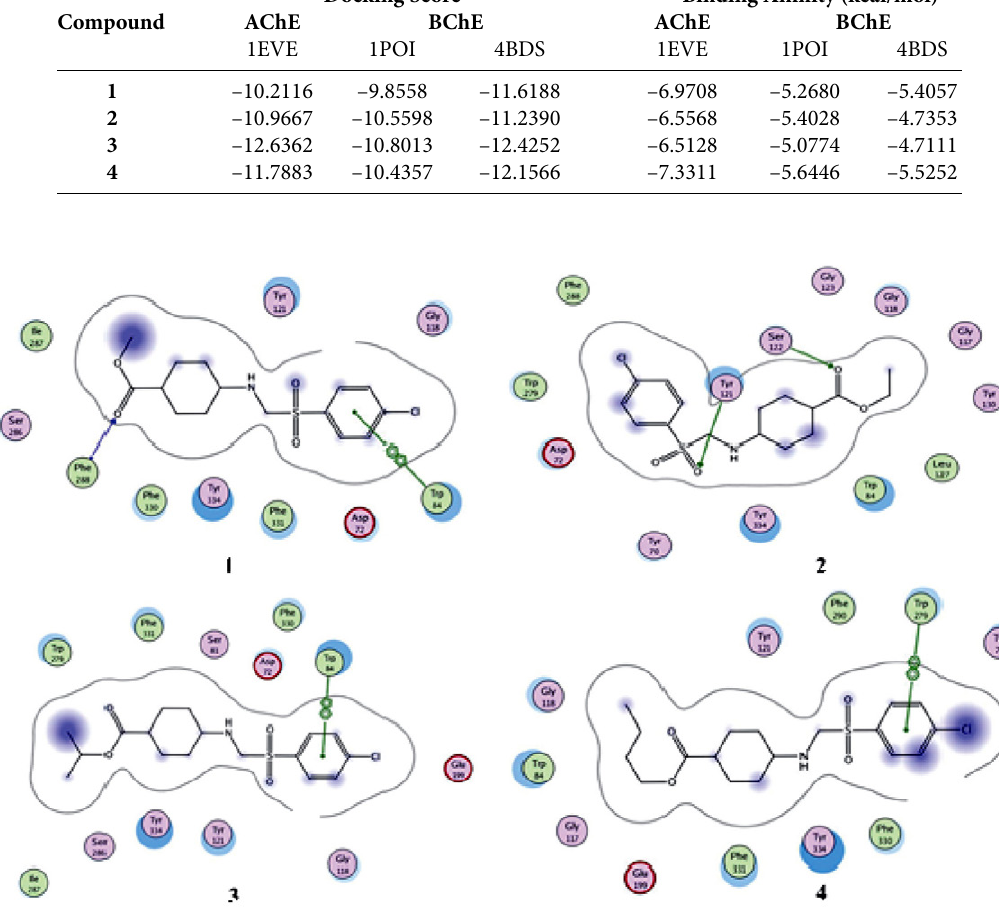
Danish et al.: Sulfonamide Derived Esters: Synthesis, Characterization, ...